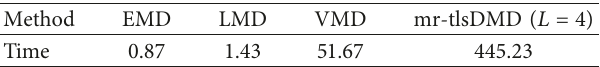
Table 12: Computational efficiency of several mode-based algo- rithms for the NASA snapshot